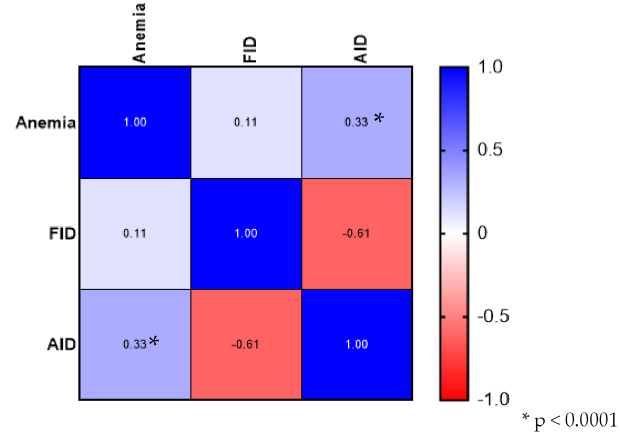
Figure 4. Analysis of correlation between anemia, FID, and AID.